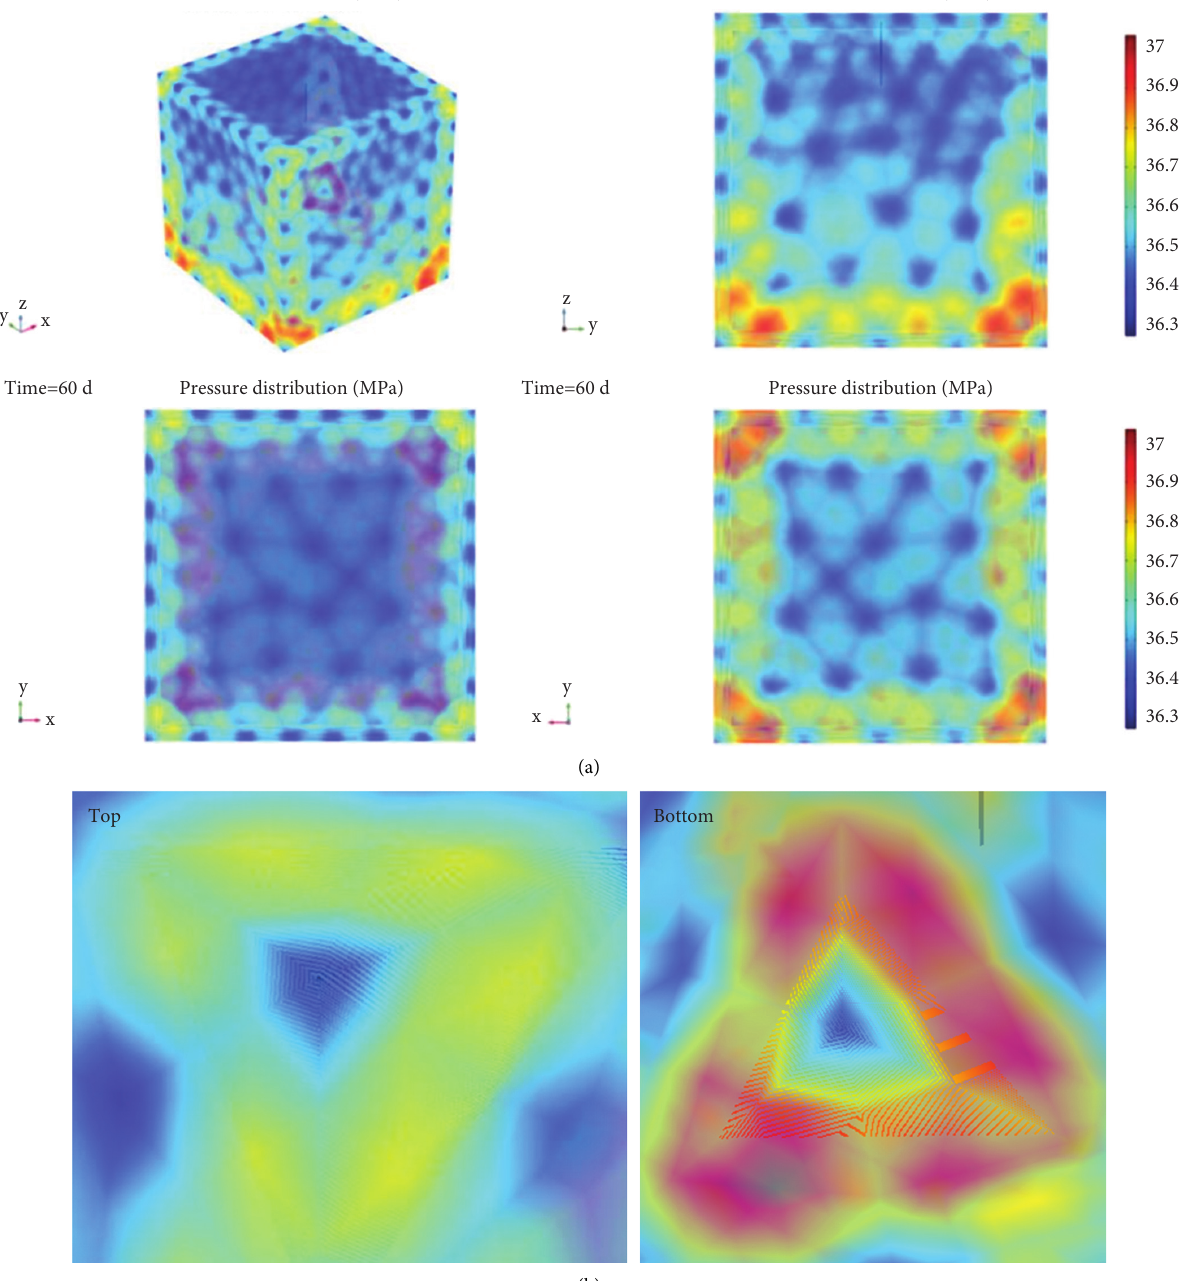
Figure 7: Three-dimensional coupling distribution: (a) different perspectives and (b) enlargement of